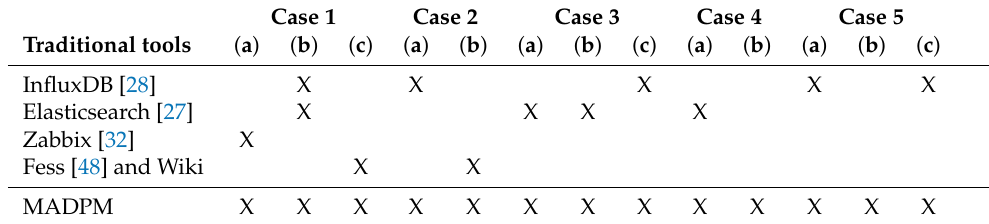
Figure 17. Comparison of heterogeneity, which is counted using the types of information provided by the prototype system. If the administrators (experimenters) collect the same types of information, they have the burden of accessing and operating the systems. Table 2. Comparison of function coverage for data presentation. Case 1 Case 2 Case 3 Case